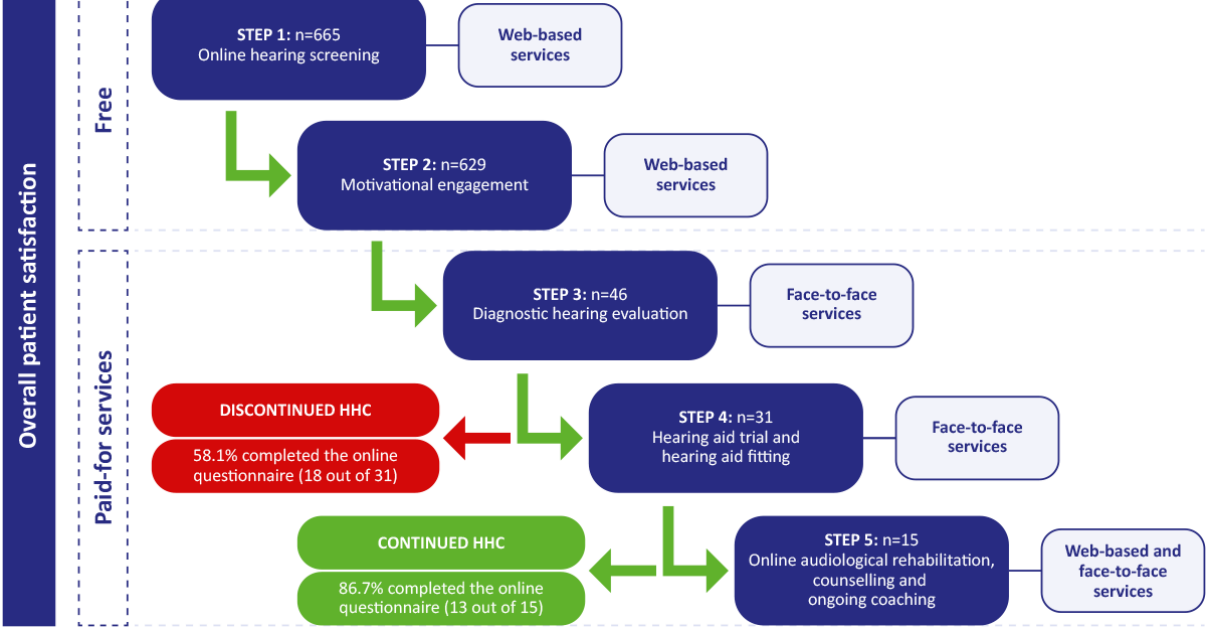
Steps in the Hybrid Hearing Health Care